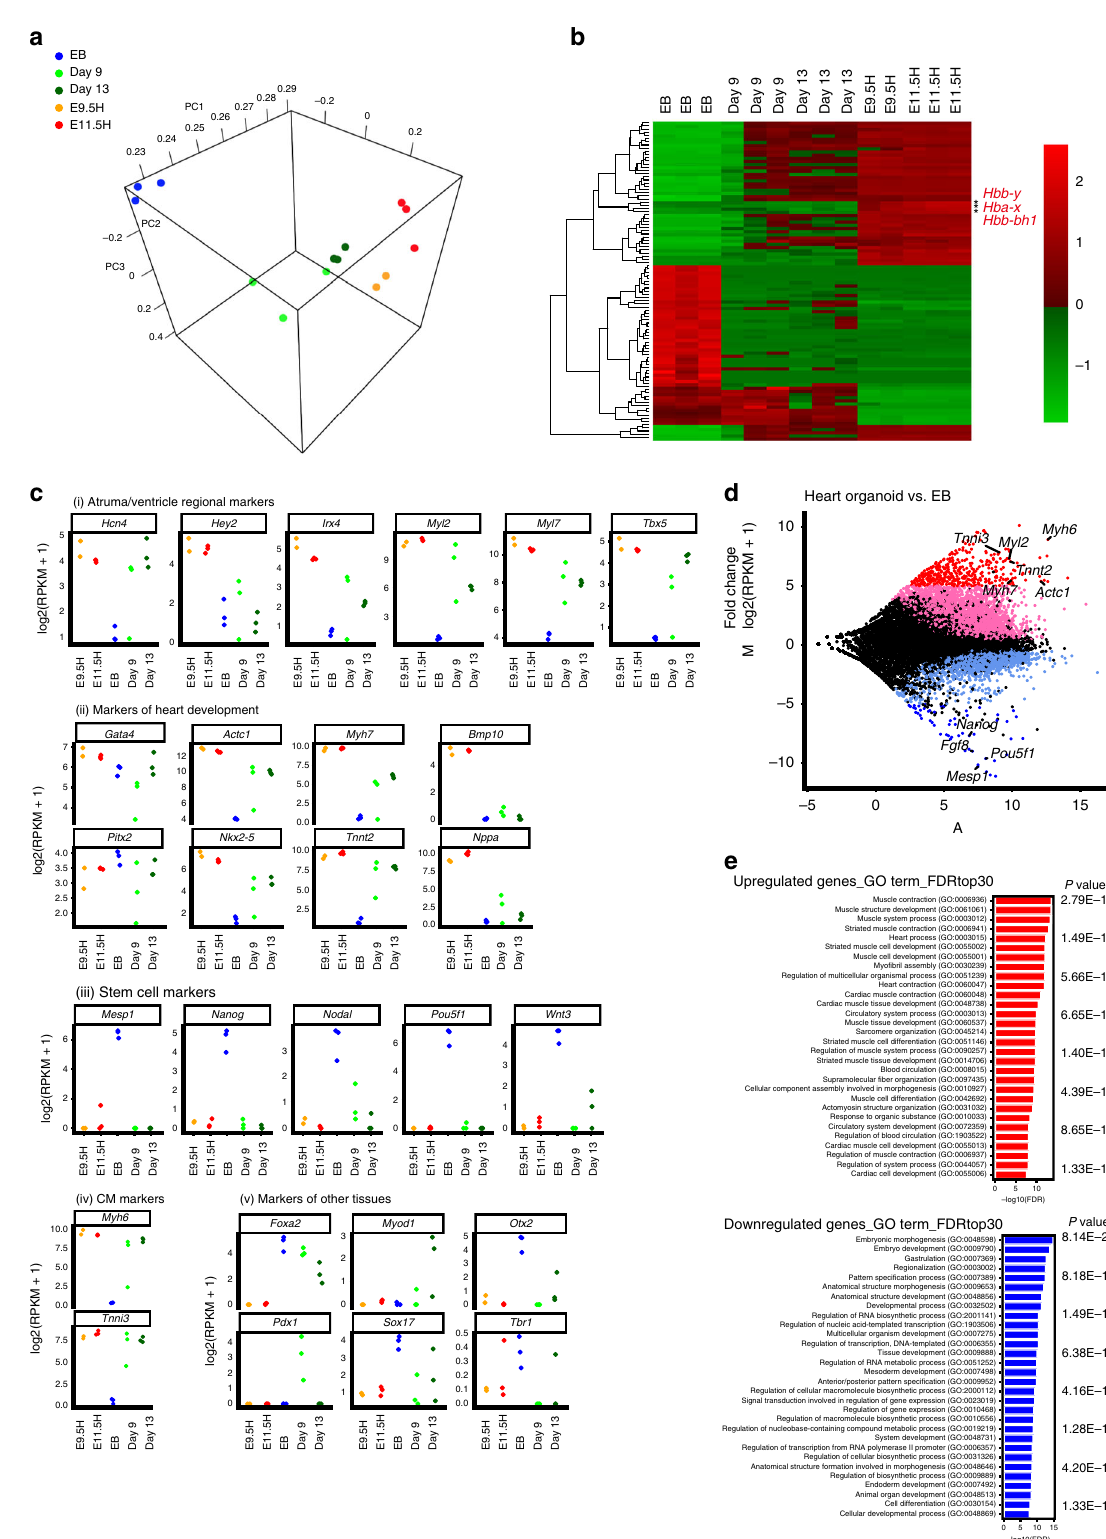
at day 11.5; for example, Col6a2 , Gstm6 , Slc7a7 showed the higher expressions in atria in vivo and atrium-like parts in heart organoids, and Cend1 , Gja1(Cx43) , Sema3c , Cspg4 , Lng1 , and Snai3 showed the higher expressions in ventricles in vivo and ventricle-like parts in heart organoids, although Bmp10 was not expressed in both atrium- and ventricle-like parts in